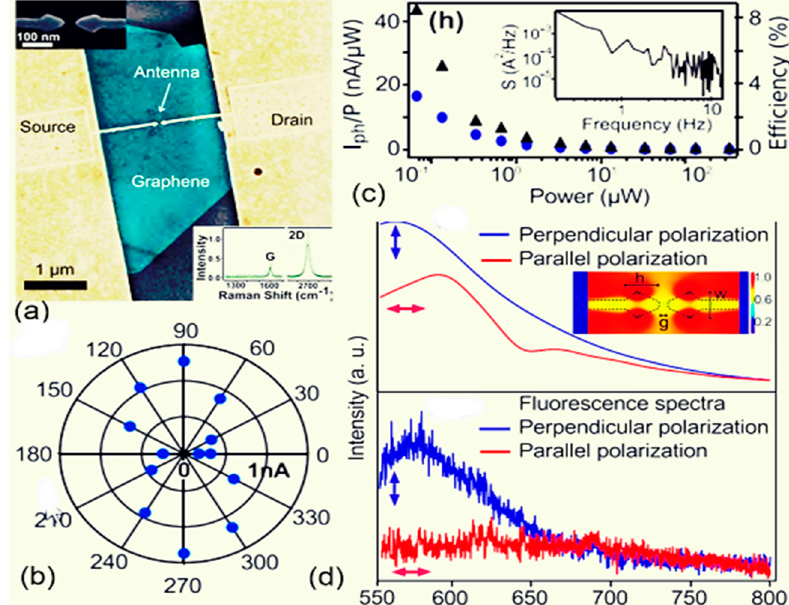
Figure 10. ( a ) Design of graphene antenna photodetector device connected with external electrodes; ( b ) 2D polar plot showing the magnitude of photocurrent and polarization isotropy of photocurrent generated from device; ( c ) external quantum efficiency and photoresponse with respect to power depicting the linear response for biasing; and ( d ) finite difference time domain (FDTD) spectra from simulation and spectra of fluorescence, which shows the polarization dependence on the luminescence of gold antenna. © 2014 AIP Publishing. Reprinted with permission from [128].